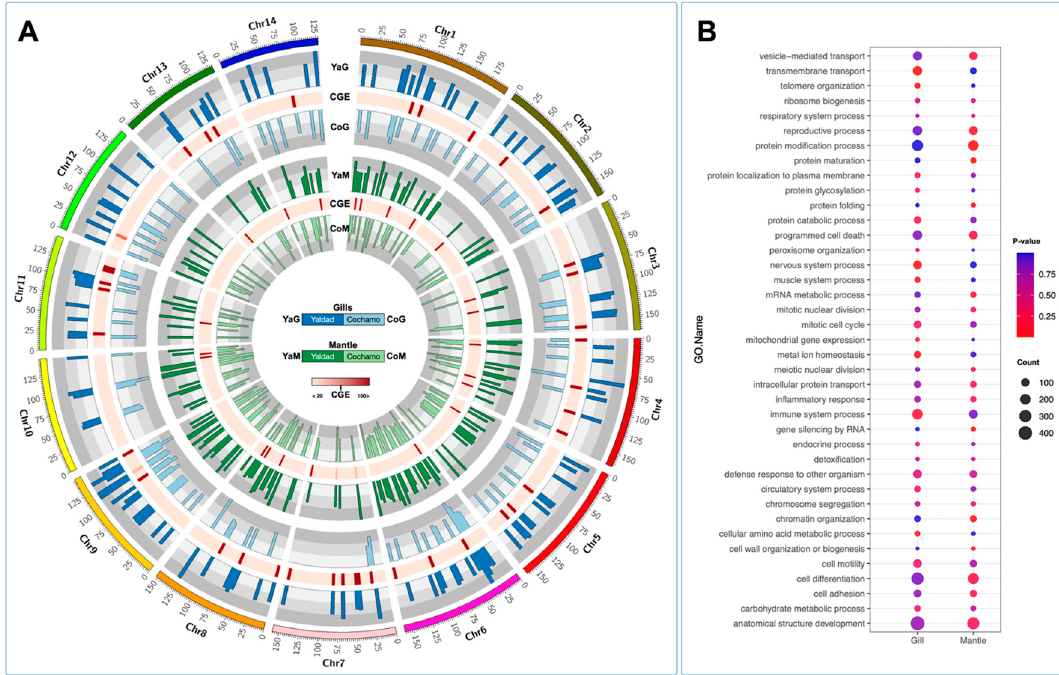
Figure 8. Chromosome–genome transcription in M. chilensis tissues collected from the Yaldad and Cochamó populations. ( A ) Circos plots showing the threshold values for transcriptional differences between locations (Yaldad/Cochamó) and tissues (gills/mantle). The differences were estimated through the CGE index. Heatmap in red shows the variation in gene expression from high to low differences. ( B ) GO enrichment of tissue-specific genes ( p -value < 10–16; |fold-change| > 5) annotated for key biological processes differentially expressed. The y -axis indicates the GO term, and the x -axis indicates the tissues analyzed. The color bar indicates the enriched factor. The bubble size indicates the number of GO terms.